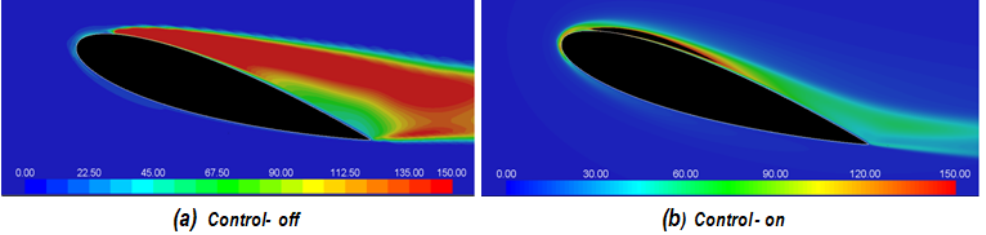
Figure 26. Contours of turbulence kinetic energy around the NACA 0015 airfoil at AoA = 16° for ( a ) control-off and ( b ) control-on case.